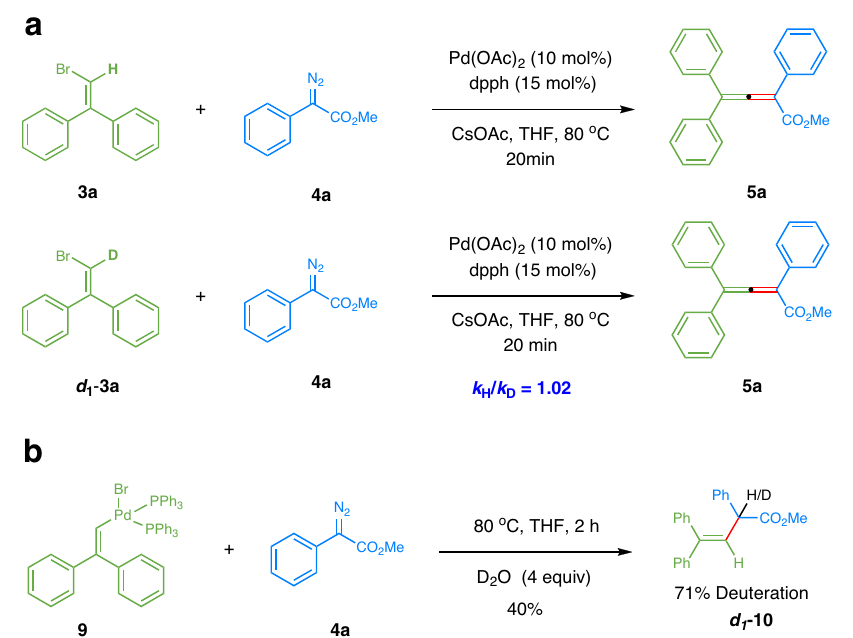
Fig. 7 KIE and deuterium-labeling experiments. a KIE determined from two parallel reactions. b Deuterium incorporation experiment.